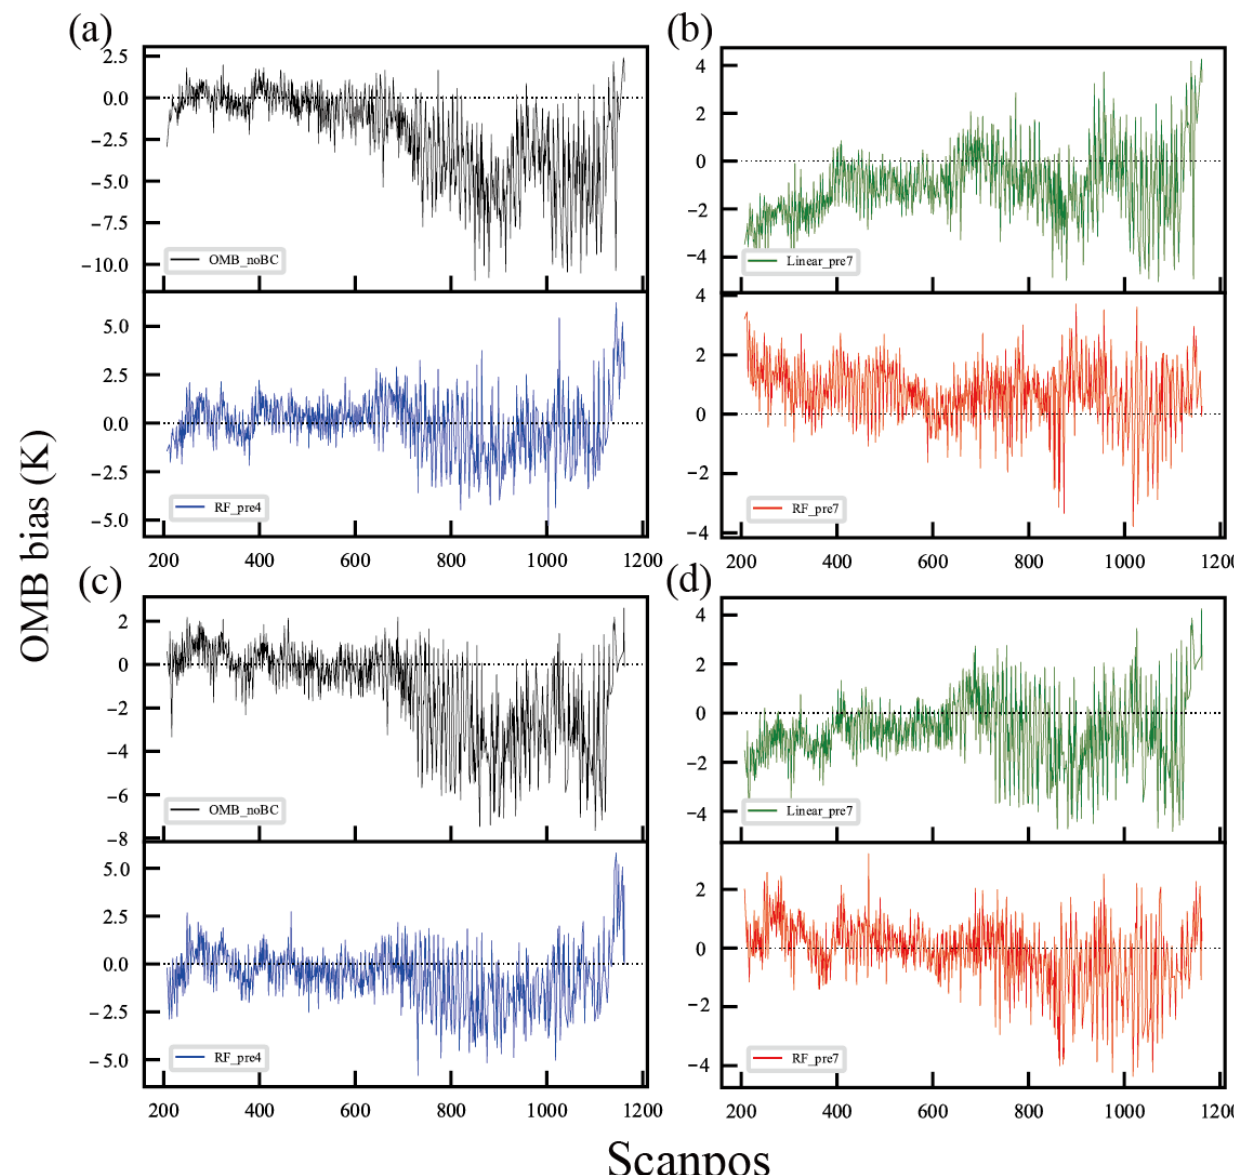
Figure 6. Variations in the average OMB biases (unit: K) with respect to the predictors of scan position (pixels number of latitudinal direction) from the different experiments for AGRI ( a , b ) channel 9 and ( c , d ) channel 10, respectively, valid at 0600 UTC 19 July 2021. ( a , c ) The left panels represent the comparison between the OMB_noBC (black lines) and RF_pre4 (blue lines) experiments. ( b , d ) The right panels represent the comparison between the OMB_noBC (black lines) and RF_pre4 (blue lines) experiments.